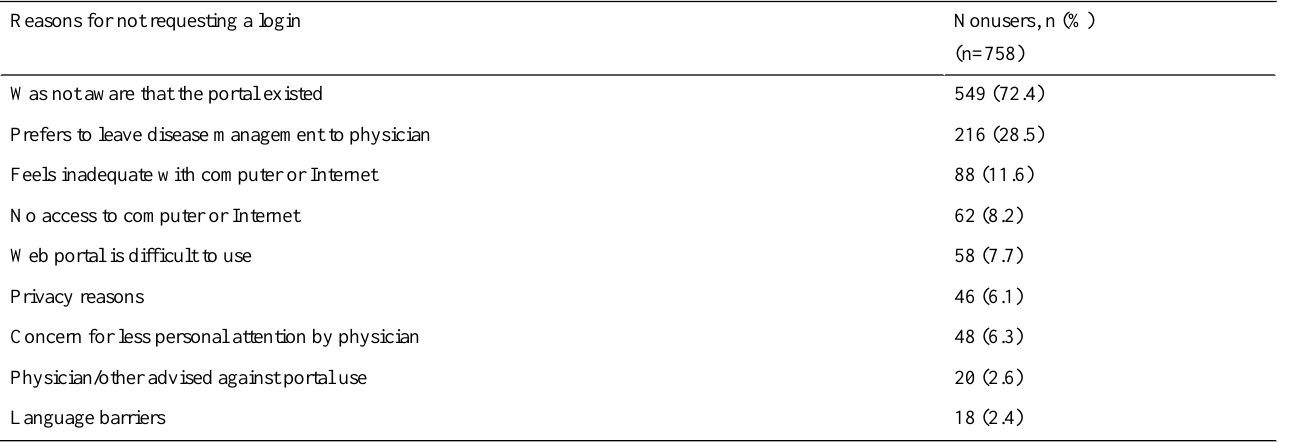
Table 3. Reasons for not requesting a login to the patient Web